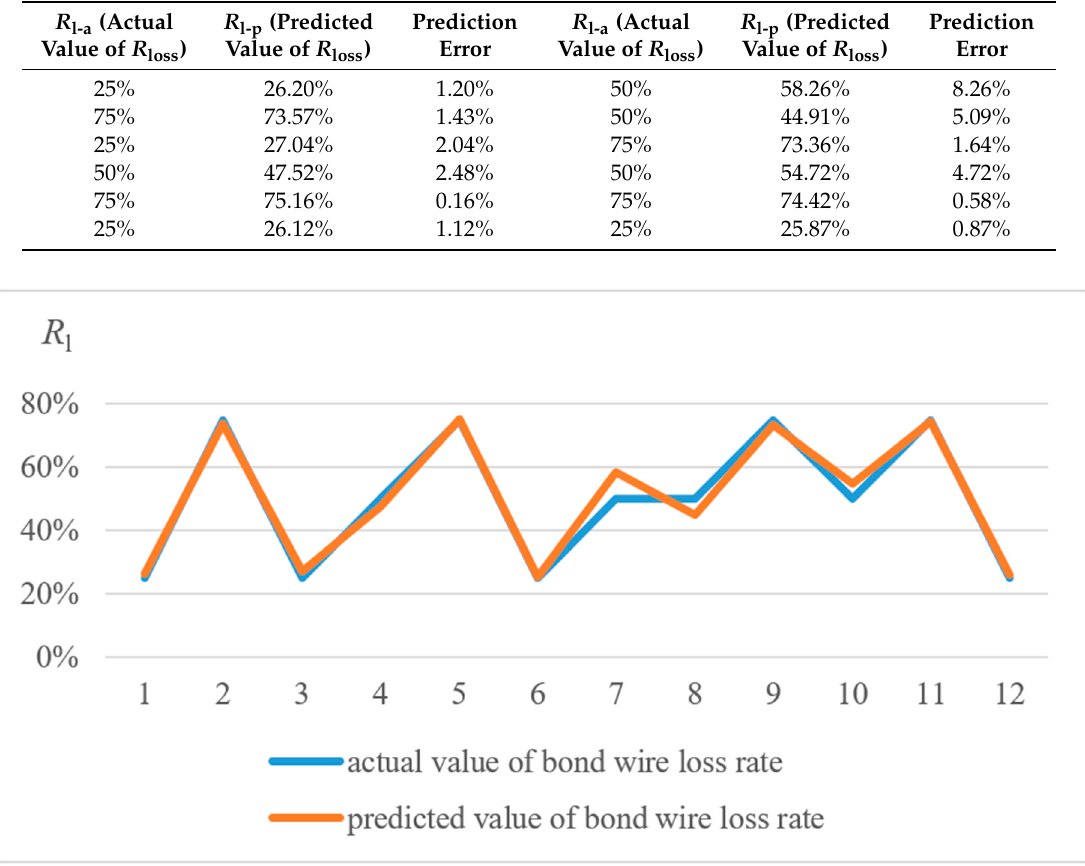
Figure 17. Diagram comparing the monitored and actual values.